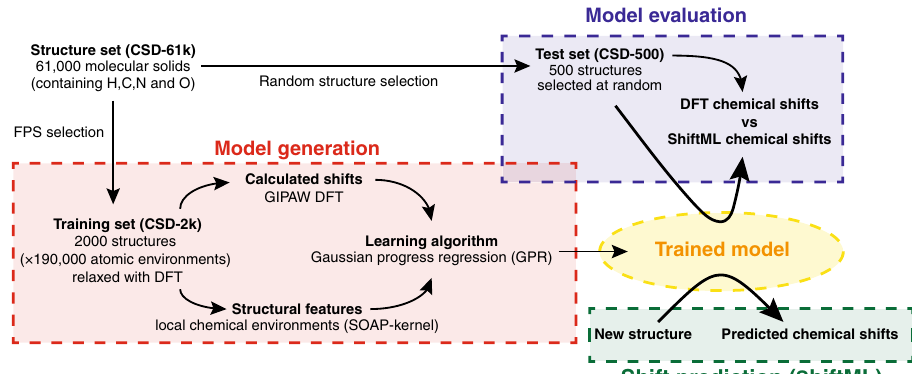
Fig. 1 Scheme of the machine learning model used for the chemical